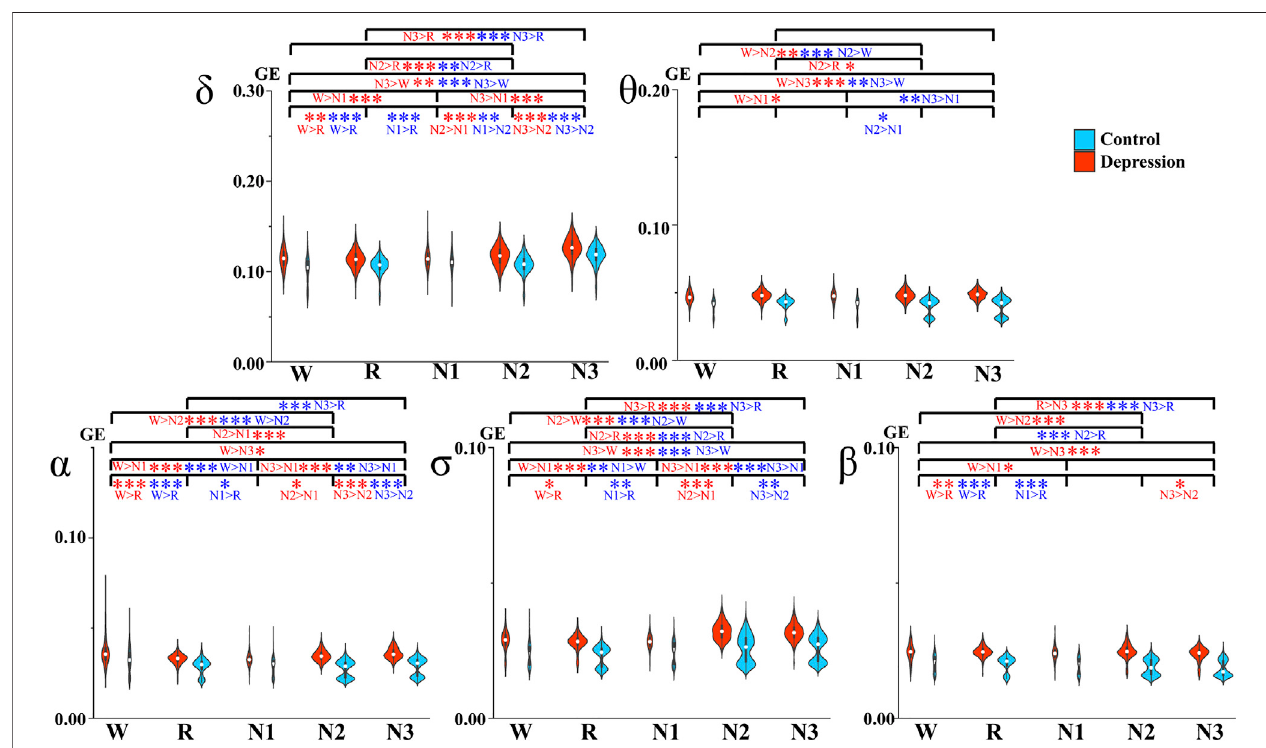
FIGURE2| Average GEbetweendifferentsleepstages. Red and blue asterisksdenote the signi fi cantdifference between twostages ofthedepressiongroup and the control group, respectively. * p < 0.05, ** p < 0.005, and *** p < 0.001 (Bonferroni correction).